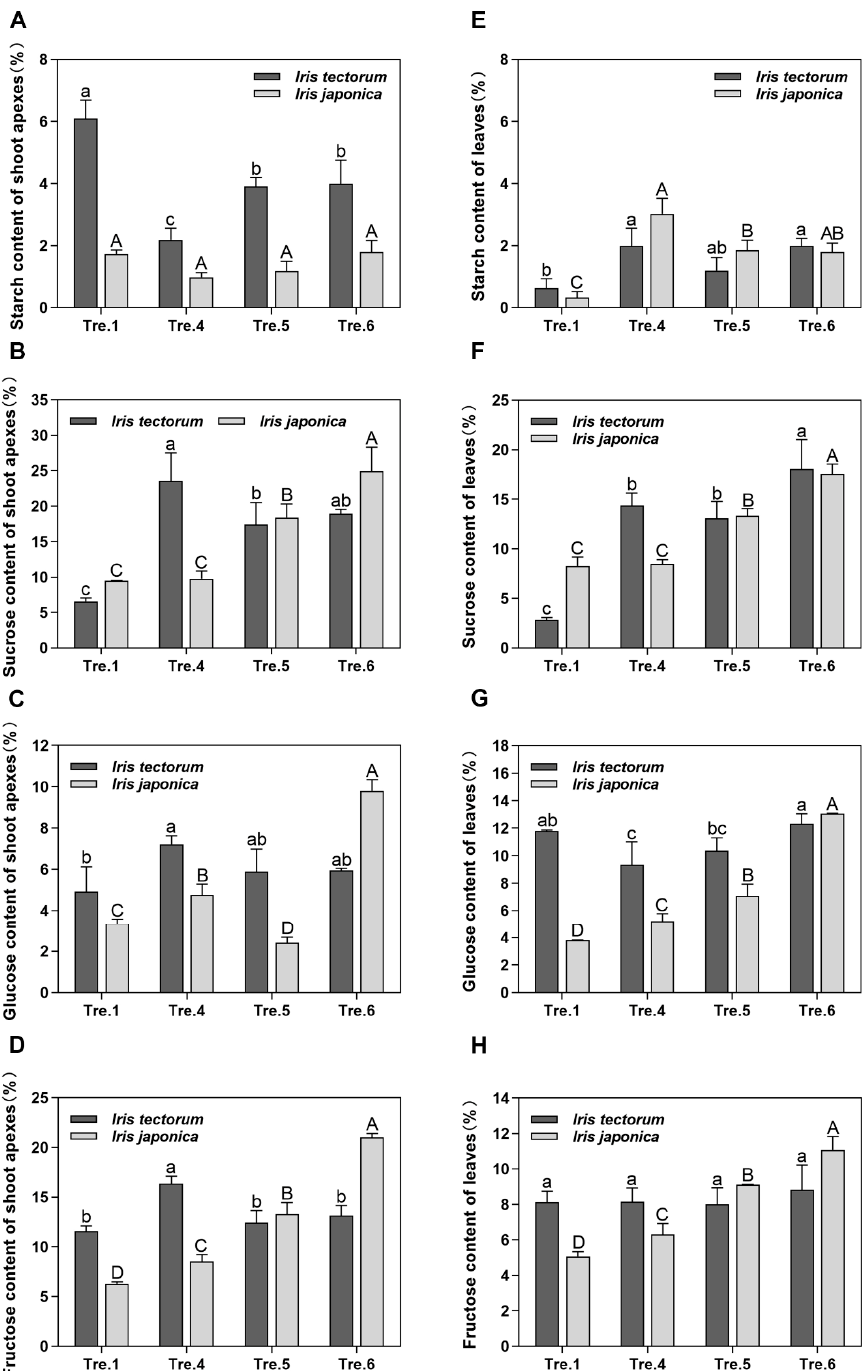
Figure 3. Changes in carbohydrate content in shoot apexes and leaves of Iris tectorum (IT) or I. japonica (IJ) under artificial dormancy induction conditions. ( A ) Starch content changes of shoot apexes in the two iris species. ( B ) Sucrose content changes of shoot apexes in the two iris species. ( C ) Glucose content changes of shoot apexes in the two iris species. ( D ) Fructose content changes of shoot apexes in the two iris species. ( E ) Starch content changes of leaves in the two iris species. ( F ) Sucrose content changes of leaves in the two iris species. ( G ) Glucose content changes of leaves in the two iris species. ( H ) Fructose content changes of leaves in the two iris species. The data in ( A – H ) are means from three biological replicates, with error bars representing standard deviation. Lowercase and uppercase letters represent significant differences for relevant parameters within IT and IJ (Duncan’s multiple comparison test p < 0.05),